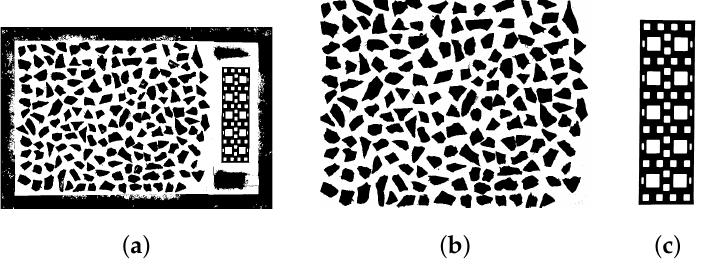
Figure A2. Image processing to compute the surface area of coconut and burn clay particles. ( a ) Bina- rized image. ( b ) Image extracted from particle sample. ( c ) Image extracted from